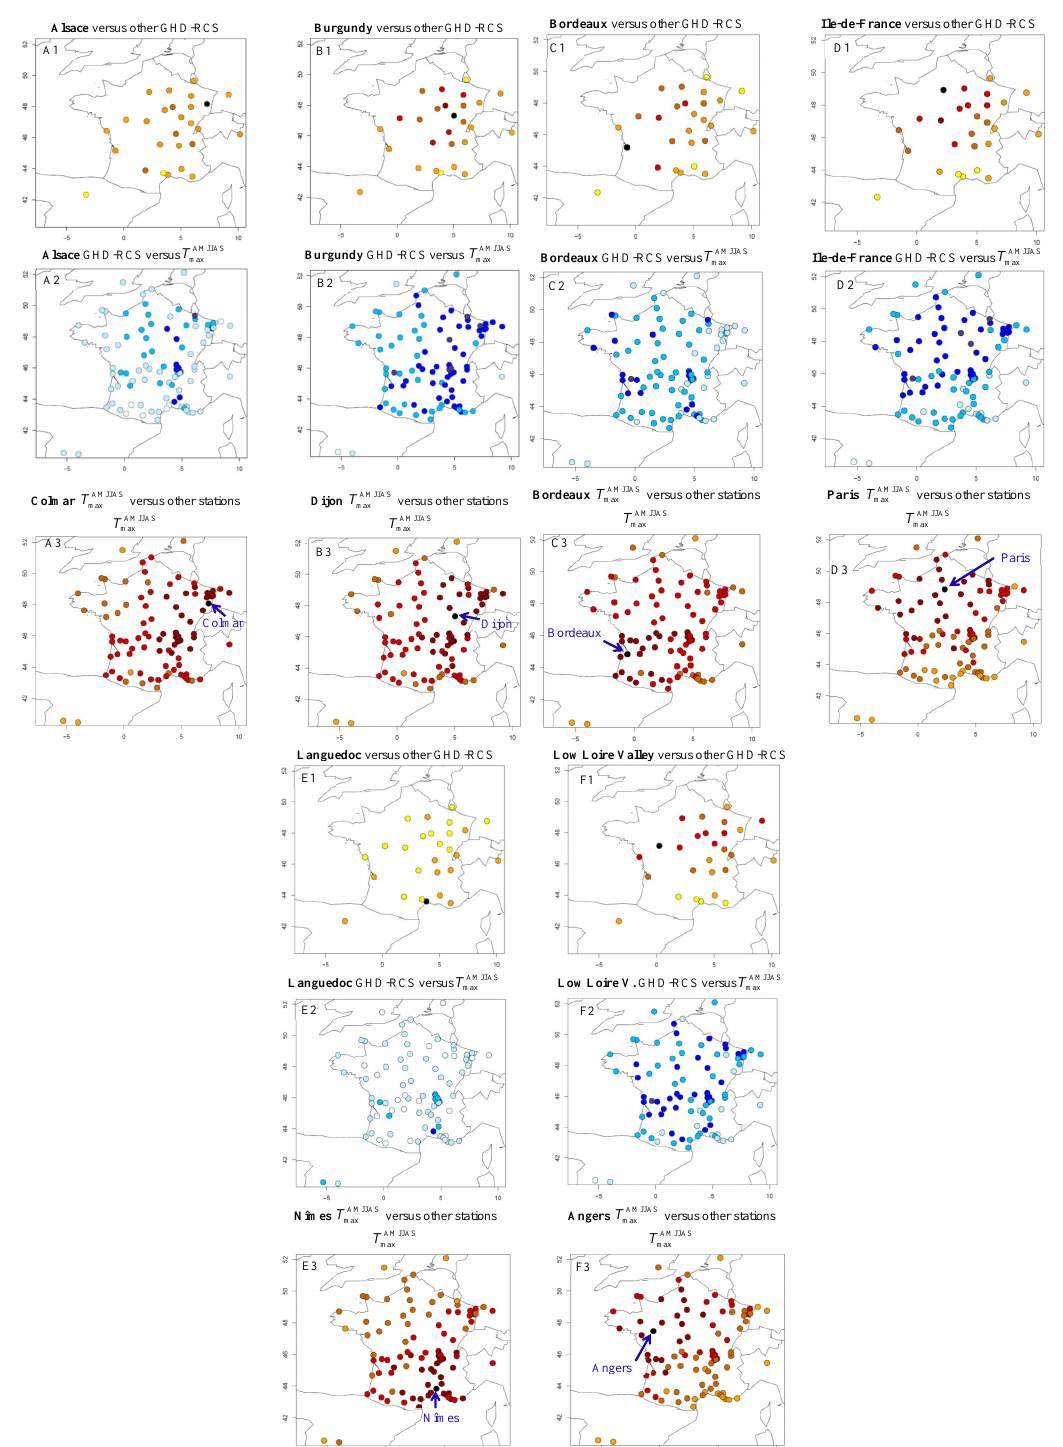
Fig. 3. Comparison of correlation maps. Top panels (1): two-by-two GHD-RCS correlations, intermediate panels (2): GHD-RCS versus T AMJJAS max correlations, bottom panels (3): pairwise T AMJJAS max correlations. Each point is centered on the location of the temperature series. Color code for top and bottom panels: value of the correlation coefficients: r = 1: black; 1 >r ≥ 0 . 9: dark-red; 0.9, >r ≥ 0 . 8: red; 0.8, >r ≥ 0 . 7: dark orange; 0.7, >r ≥ 0 . 6: orange; 0.6 , >r ≥ 0 . 4: light orange; 0.4, >r ≥ 0: yellow. Color code for middle panel: − 1 ≤ r ≤− 0.9: black; − 0.9 <r ≤− 0.8; dark blue; − 0.8 <r ≤− 0.7; blue: − 0.7 <r ≤− 0.6: sky blue; − 0.6 <r ≤− 0.4: pale blue; − 0.4 <r ≤ 0: bluish